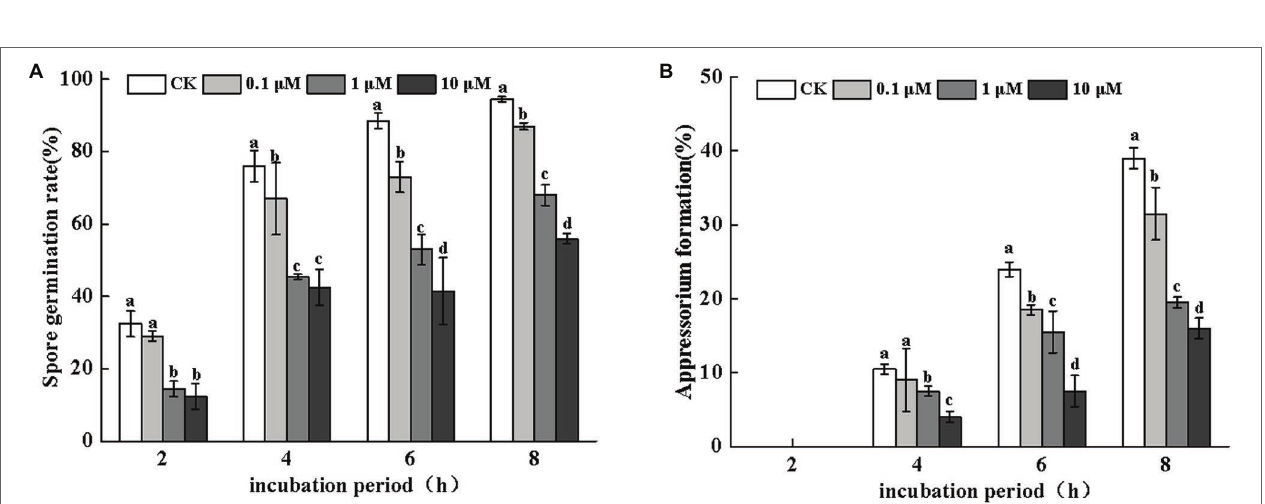
FIGURE 2 | Relative expression levels of AaPLC1 , AaPLC2 , and AaPLC3 during infection. Vertical lines indicate the standard error (± SE ) of the means. Uppercase letters indicate inter-group differences. Lowercase letters indicate intra-group differences. Different letters indicate significant differences ( p <